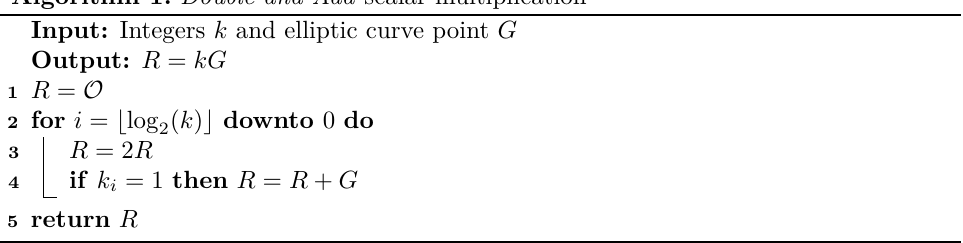
Algorithm 1: Double-and-Add scalar multiplication